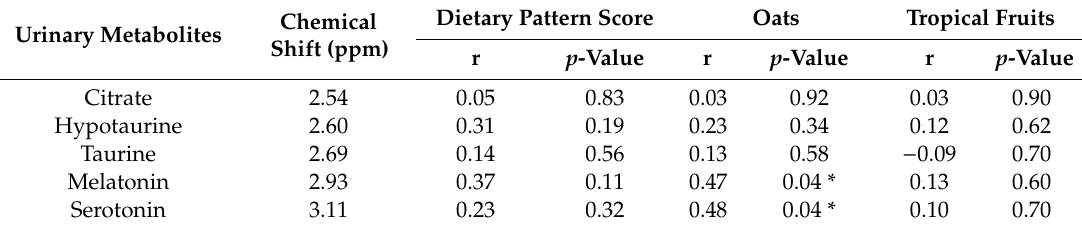
food food groups.